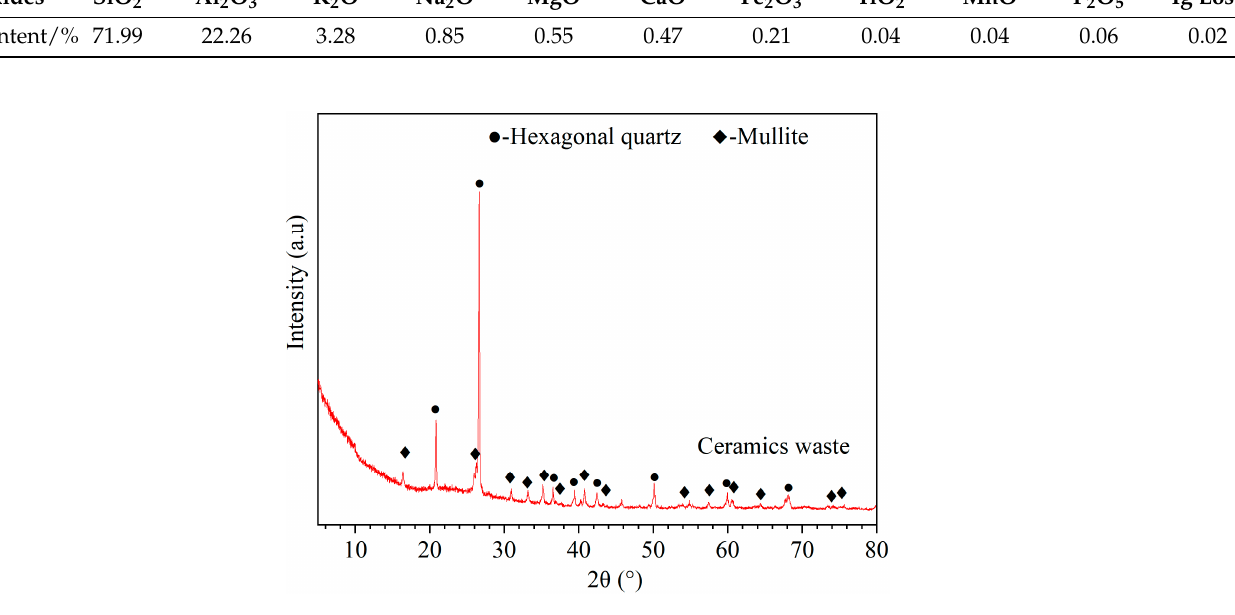
Table 3. Chemical composition of pretreated ceramic wastes (in mass fraction).